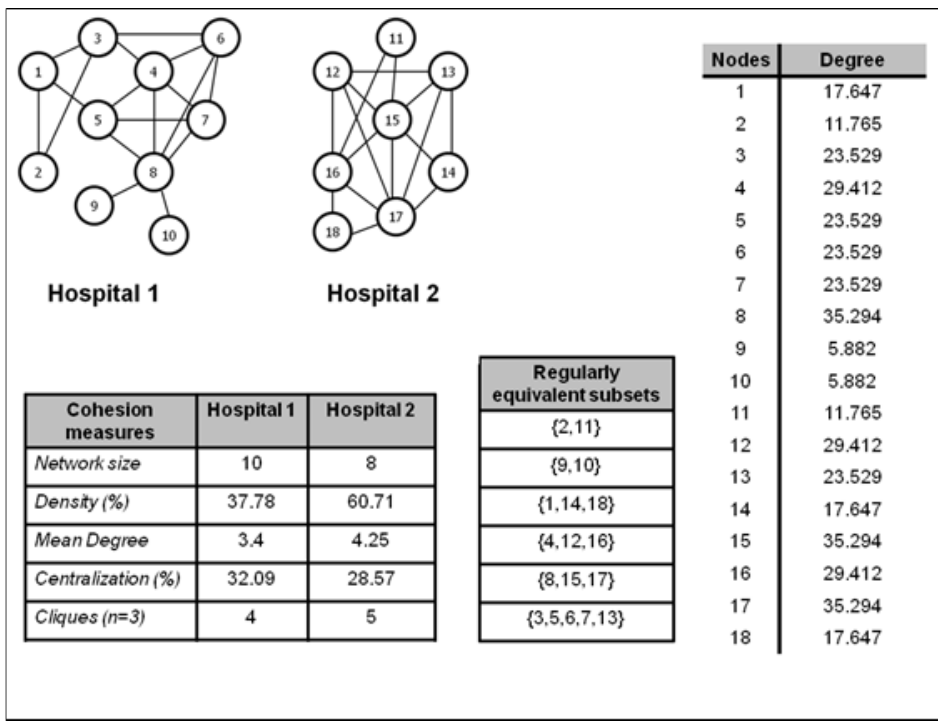
Figure 2. Illustration of role equivalence identifying the regularly equivalent subsets of actors, the cohesion measures of the networks of the two hypothetical hospitals, and the degree centrality of all nodes.